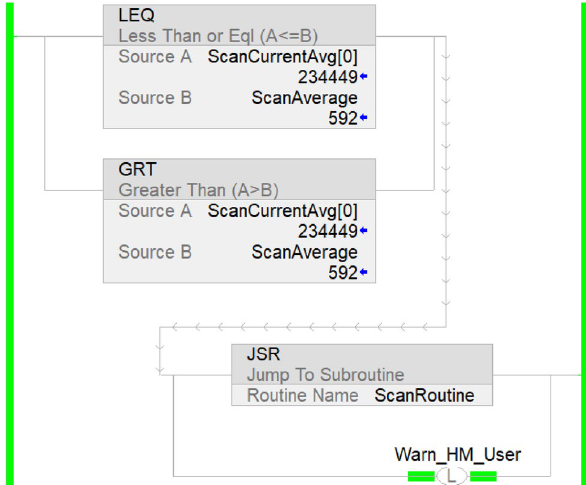
Fig. 24 Preventing further logic scanning and alerting